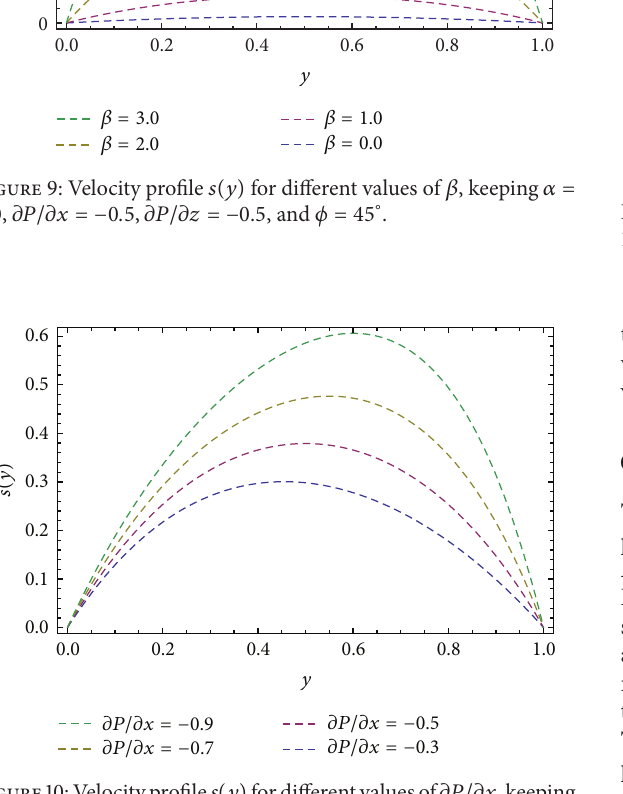
Figure10:Velocityprofile 𝑠(𝑦) fordifferentvaluesof 𝜕𝑃/𝜕𝑥 ,keeping 𝛼 = 1.0 , 𝛽 = 1.0 , 𝜕𝑃/𝜕𝑧 = −0.5 , and 𝜙 = 45 ∘ .